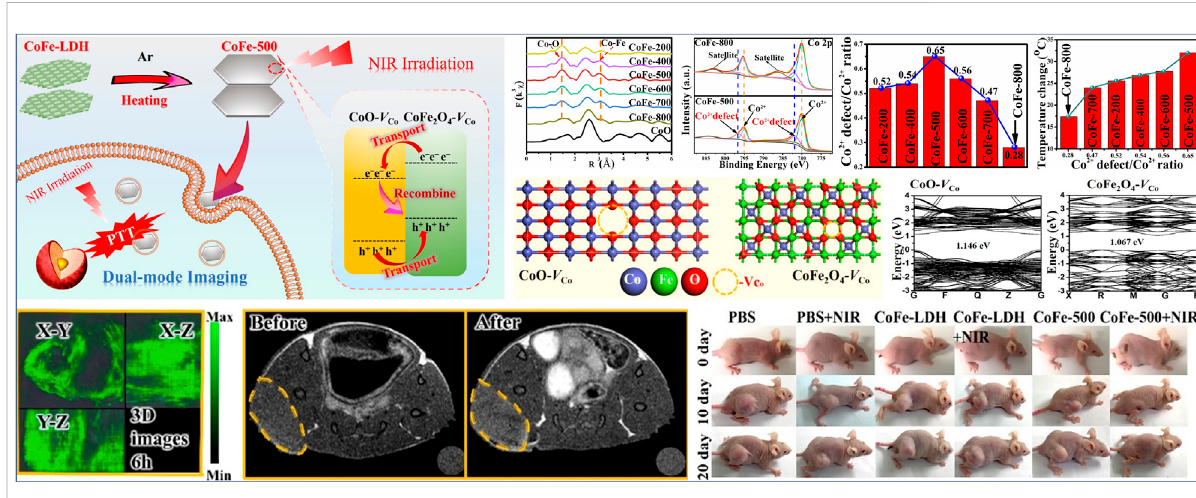
FIGURE 6 Schematic Illustration of the synthesis of CoFe-500 for PA/MR/NIR imaging-guided PTT, Fourier-transform EXAFS spectra at Co K-edge for various CoFe-x samples, Co 2p XPS spectra for CoFe-500 and CoFe-800, Co 2+ defect/Co 2+ peak area ratio for various CoFe-x samples, and optimized geometries for a CoFe-500 bulk heterojunction composed of CoO-V Co and CoFe 2 O 4 -V Co , band structures of CoO-V Co and CoFe 2 O 4 - V Co , 3D PAI images of tumor site at 6 h postinjection, in vivo T1-MRI imaging of HeLa-bearing mice before and after injected with CoFe-500, and photographs at different times after various treatments. Reproduced with permission from Wang L. et al. (2021). Copyright © 2020 American Chemical